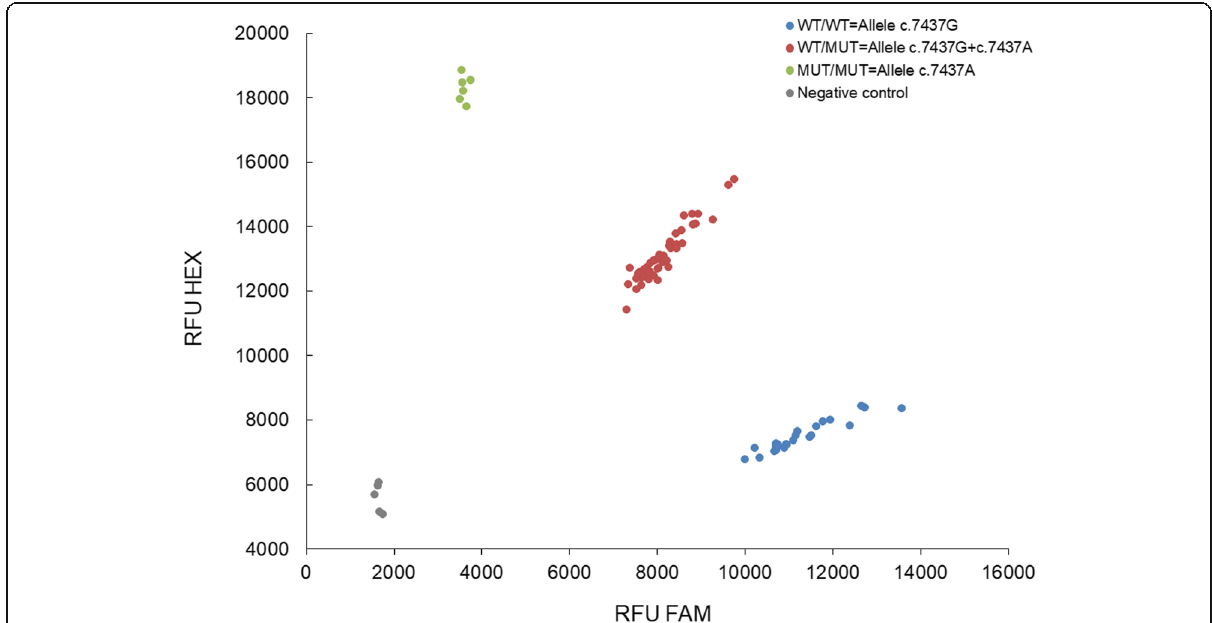
Fig. 2 Example of vWDI genotyping in Kromfohrländer. Endpoint genotyping against c.7437G > A was used to identify the genotypes. Blue cluster = wild-type (WT/WT) with allele c.7437G, red cluster = heterozygous (WT/MUT) with both alleles (WT) c.7437G + mutated (MUT) allele c.7437A, green cluster = homozygous (MUT/MUT) with the vWDI related allele c.7437A. Controls of known genotypes were used in replicates for each cluster. Negative controls without template are shown in grey